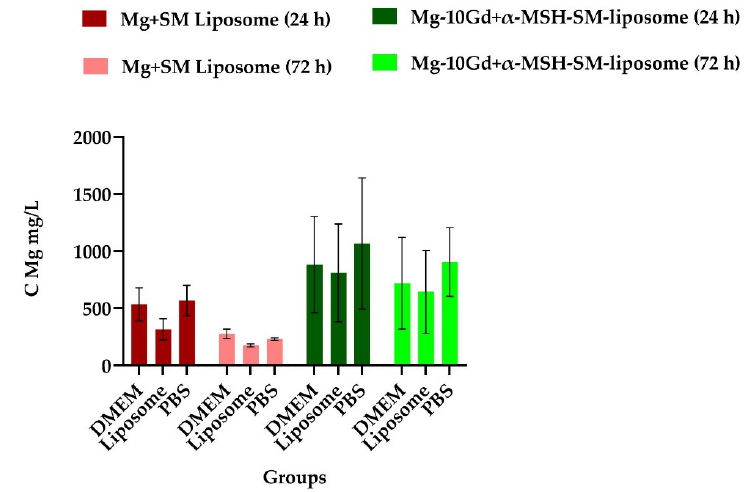
Figure 3. A liposome immersion assay was performed in liposome solution (20 µM, 1:25 dilution in DMEM) to study the degradation rate. DMEM and PBS were used as a control solution. The degradation was performed, and as a control, Mg discs were studied with SM-liposomes. Data are expressed as the mean ± standard error of the six samples per group ( p < 0.05). The results indicate no change in the degradation pattern in the presence of the liposomes for the 24 h and 72 h time ranges.